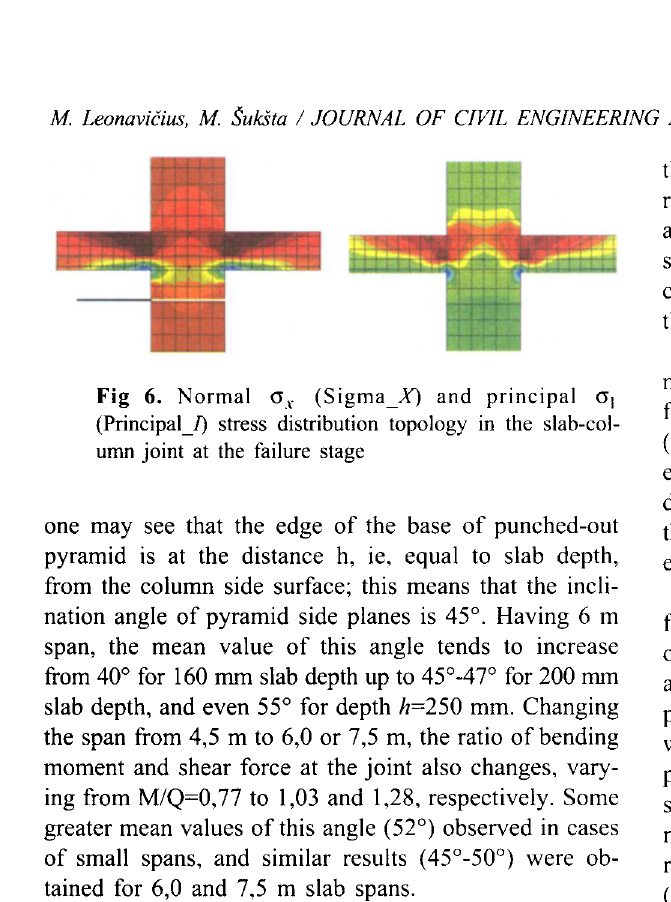
(Principal_l) stress distribution topology in the slab rein forced by longitudinal bars in the slab-column joint at the failure stage